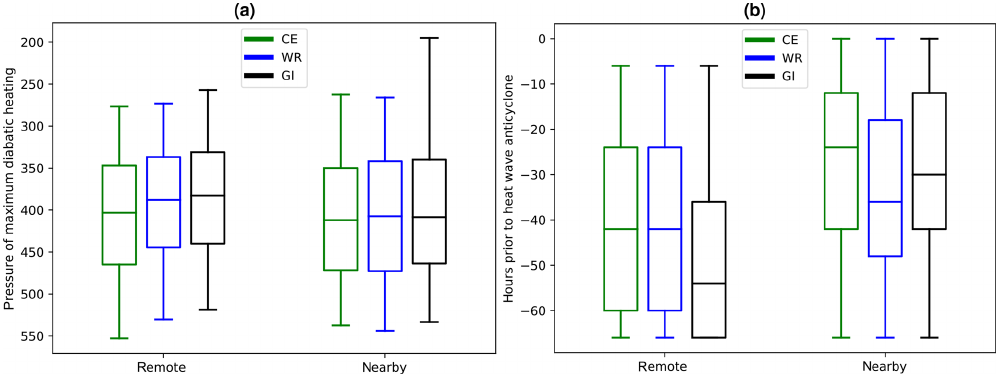
Figure 7. Pressure (a) and time (b) of maximum diabatic heating of trajectories in the two heating branches of the heat wave anticyclone over central Europe (green: CE), western Russia (blue: WR) and Greece–Italy (black: GI). Horizontal lines denote the median, the boxes the interquartile range, and the whiskers the 5th and 95th